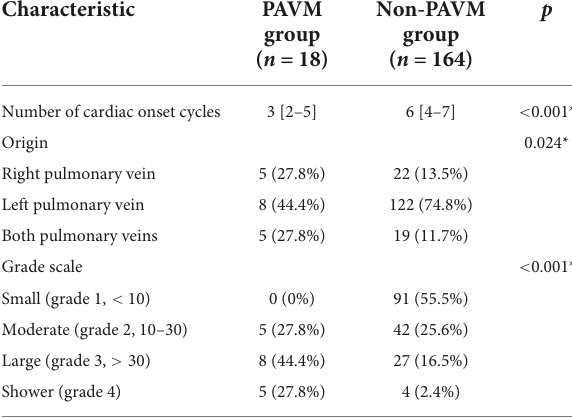
TABLE 3 Transesophageal contrast echocardiography with agitated saline test parameters. Characteristic